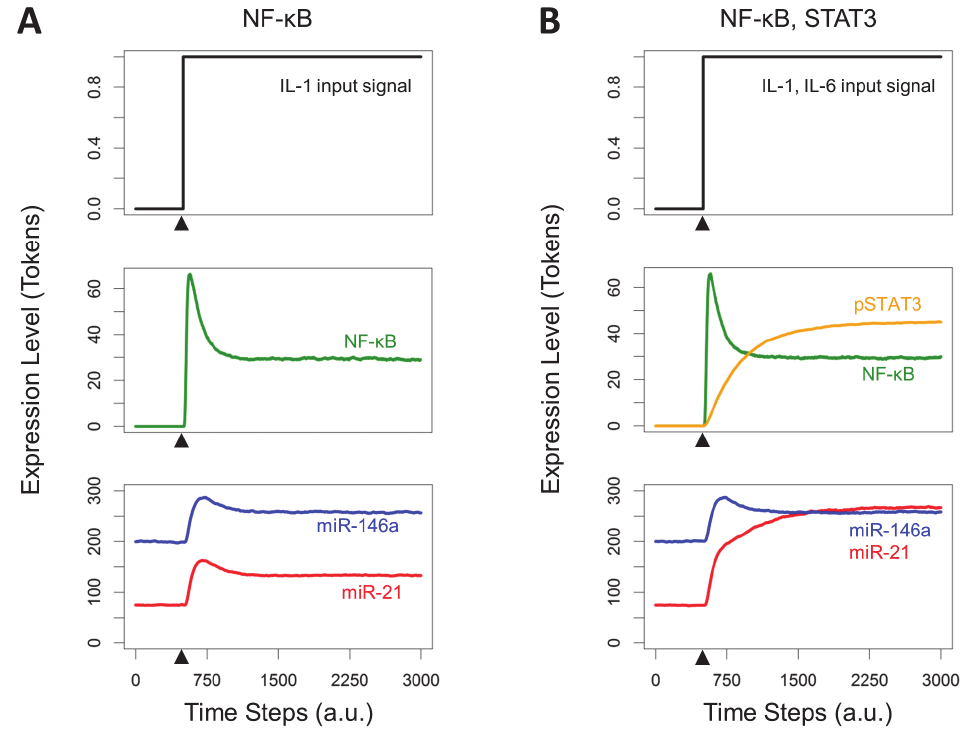
Figure 4. Dynamics of microRNA and transcription factor expression levels during HSC activation. ( A ) Expression levels considering the IL-1/NF- κ B signaling pathway alone; ( B ) Expression levels considering IL-1/NF- κ B and IL-6/STAT3 signaling pathways regulating the microRNAs. Solid arrowheads mark the start of input cytokine